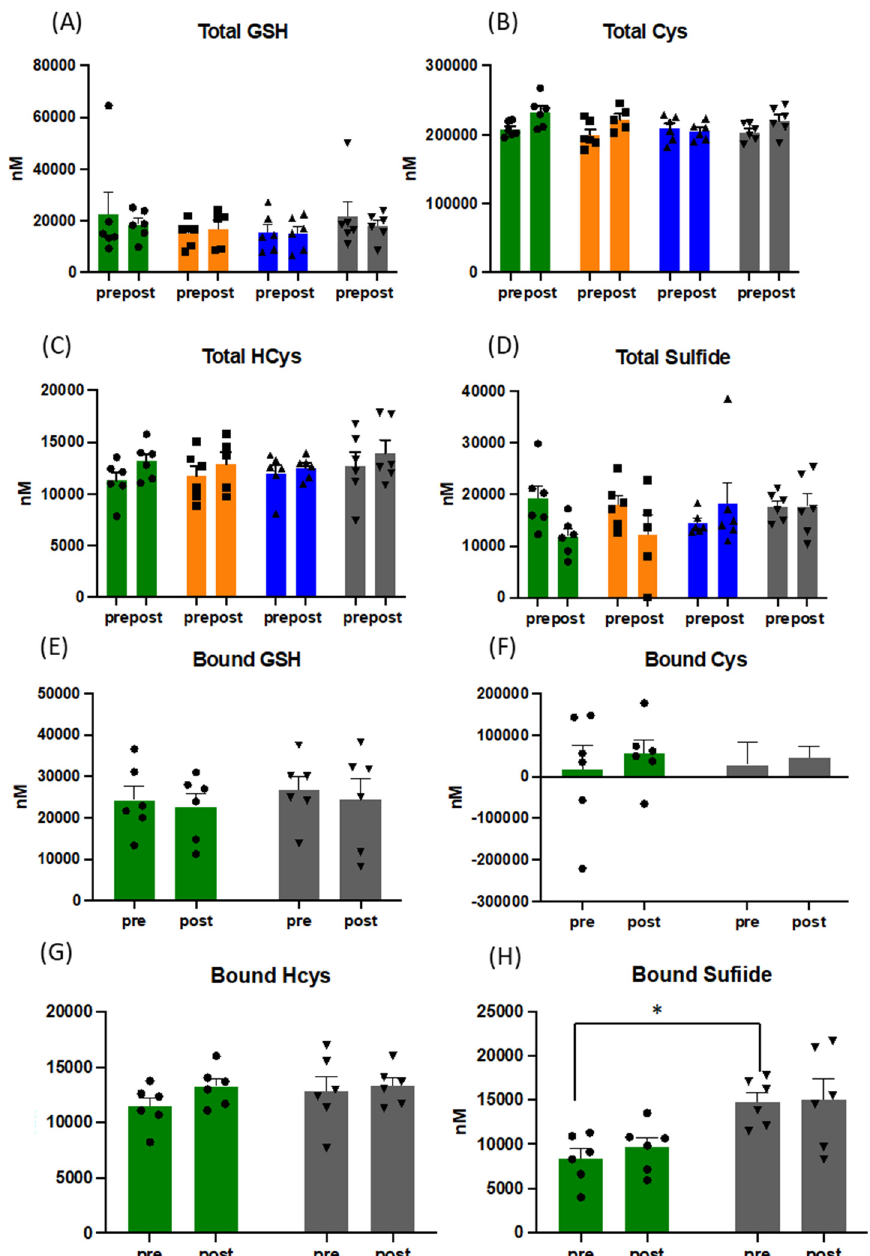
Figure 2. Pattern of response to changes in concentration of total and bound thiols in plasma ( A – H ). Data presented for before and after acute physiological challenge of a cardiopulmonary exercise test at each sampling point throughout the training intervention, presented as mean and SEM, with overlaid individual data (circles, squares and triangles; for the sake of direct comparison to free thiols, all concentrations are presented in [nM]). Green bars = baseline, orange bars = week 3, blue bars = week 6, and grey bars = week 12. Abbreviations: GSH: gluthathione; Cys: cysteine; HCys: homocysteine, * = p < 0.05.